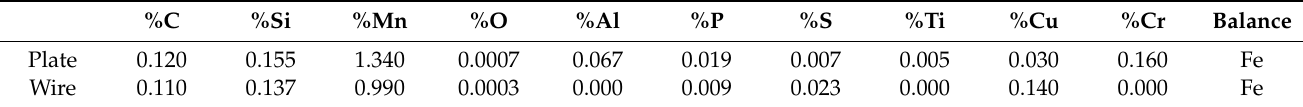
Table 1. Carbon steel base plate and weld wire compositions (mass%) [29].